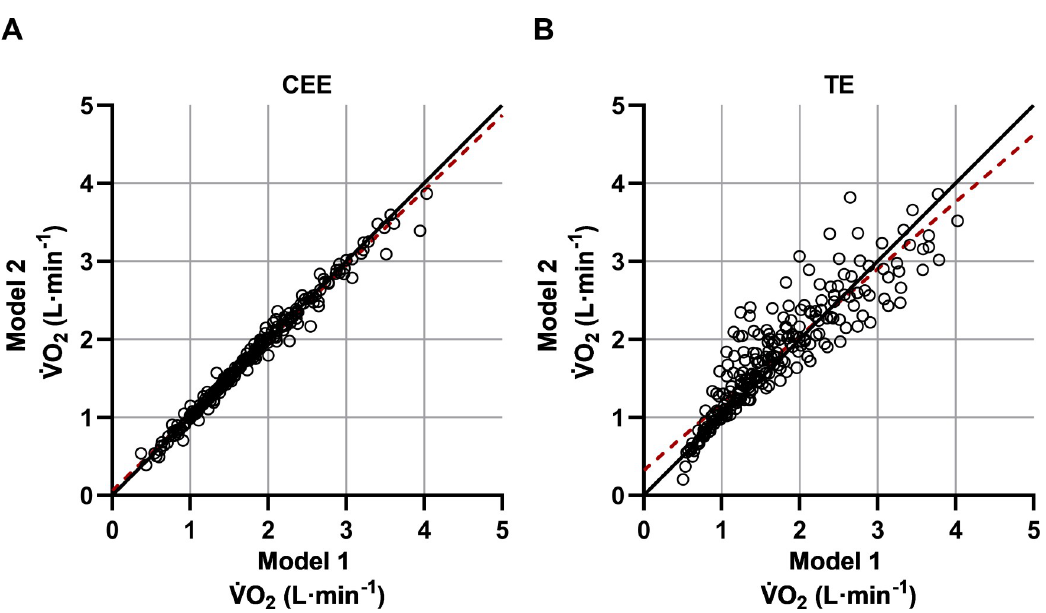
Fig 4. Comparison of the estimated individual _ V _ O values between model 1 and model 2 in cycle ergometer exercise (CEE) 2 and treadmill exercise (TE). Based on all participants (n = 34), ranging between 25–85% of HRR. The overall linear regression equations (red dashed lines) with 95% CI and r-coefficients were: CEE (A) y( _ V _ O Model 2) = 0.056(0.028 ─ 0.084) + 0.9632 2 Model 1) and r-coefficient = 0.993. TE (B) y( _ V _ O Model 2) = 0.318(0.223 ─ 0.413) + 0.8606 (0.9483 ─ 0.9780) � x( _ V _ O 2 2 (0.8091 ─ 0.9122) � x( _ V _ O Model 1) and r-coefficient = 2